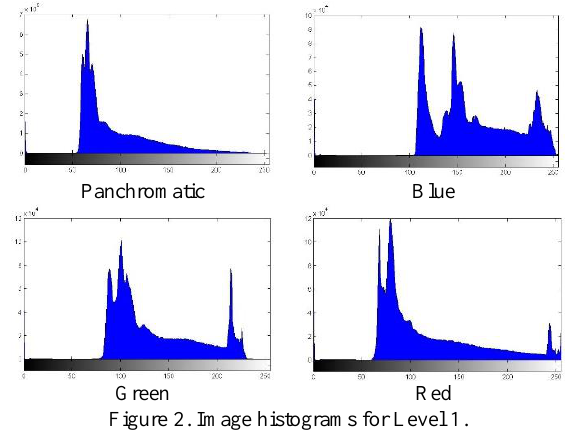
Figure 2. Image histograms for Level